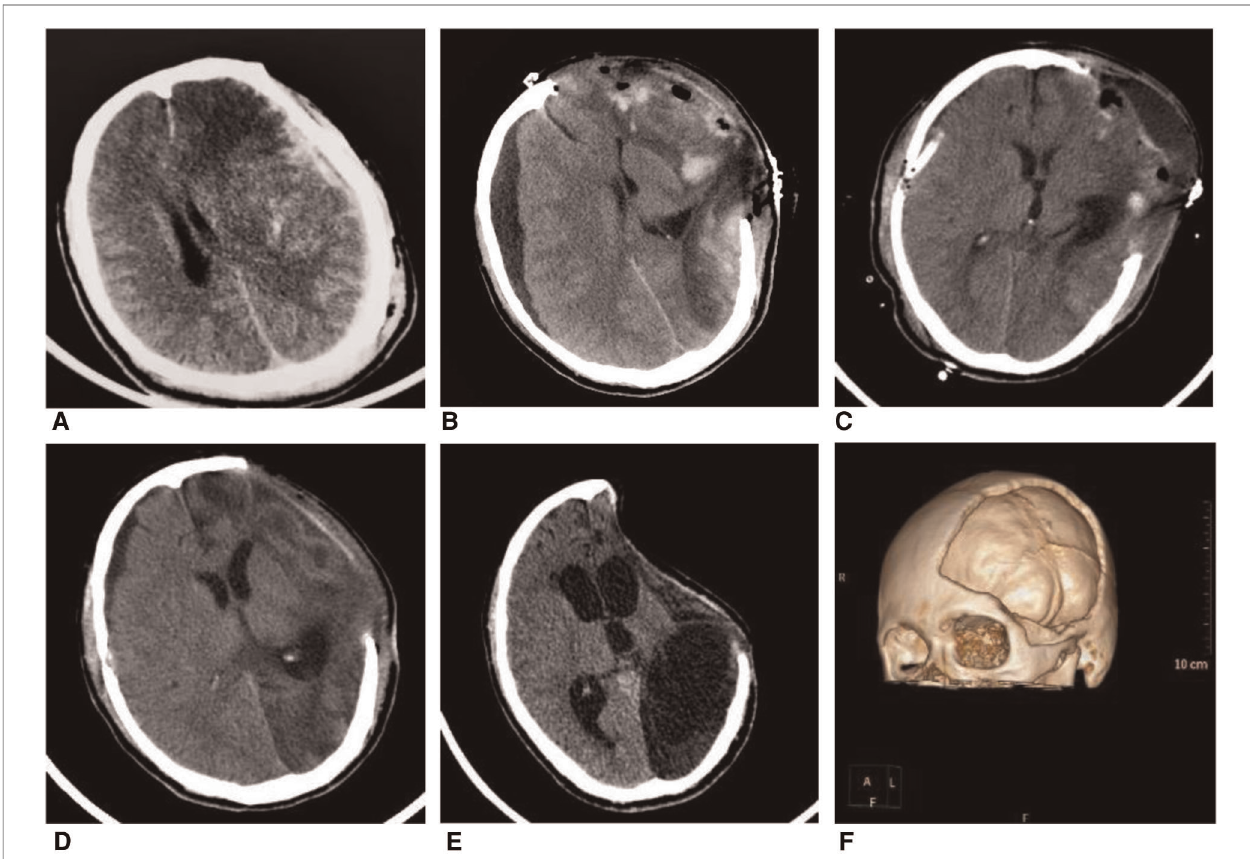
FIGURE 3 | A 31-year-old man fell from a height of three meters after electric shock, whose GCS is 4 points at admission. Patient received decompressive craniectomy (DC) and absorbable dura repairment. ( A ) Computed tomography (CT) image at admission showed an acute subdural hematoma on the left side. ( B ) CT at 11 days after DC showed subdural hygroma on the right side and herniation of brain tissue on the left side. ( C ) Patient received burr hole irrigation and drainage 13 days after DC, postoperative CT showed the reduction of subdural hygroma. ( D ) CT at one month after DC showed shrinkage of left-sided brain tissue ( E ) Six months after DC, CT indicated the syndrome of the trephined ( F ) 3D reconstruction of the CT scan of this patient after